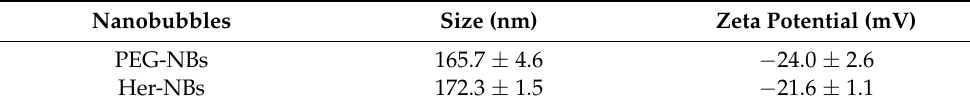
Table 1. Average particle size and zeta potential of PEG-NBs and Her-NBs ( n = 3).